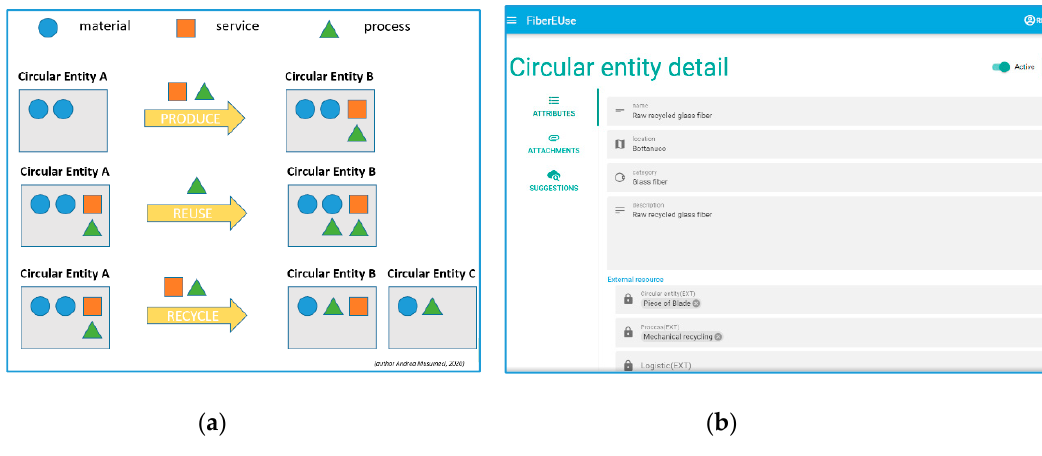
Figure 5. FiberEUse circular entity: theory ( a ) and implementation ( b